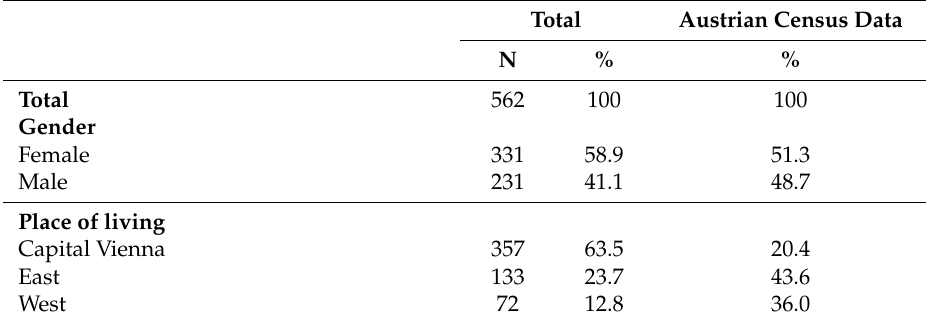
Table 1. Socio-demographic characteristics of the study population and the Austrian census data from